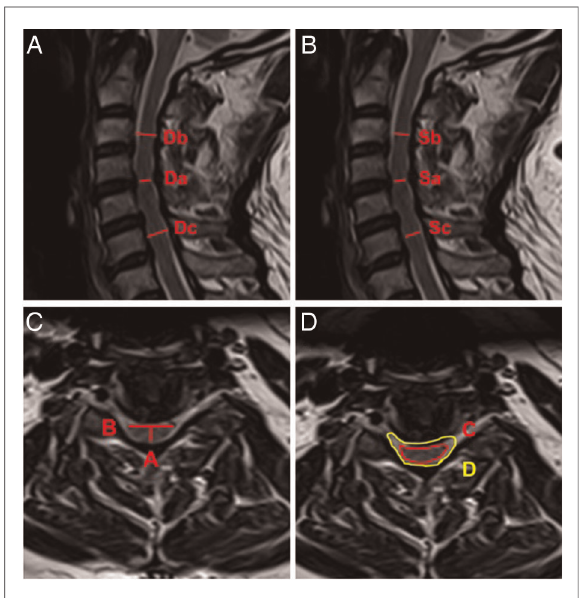
FIGURE 1 Schematic diagram of spinal cord compression parameter measurement on MRI. ( A ) MCC=[1 − 2Da/(Db+Dc)]×100%. ( B ) MSCC=[1 − 2Sa/(Sb+Sc)]×100%. ( C ) CR=A/B×100%. ( D )